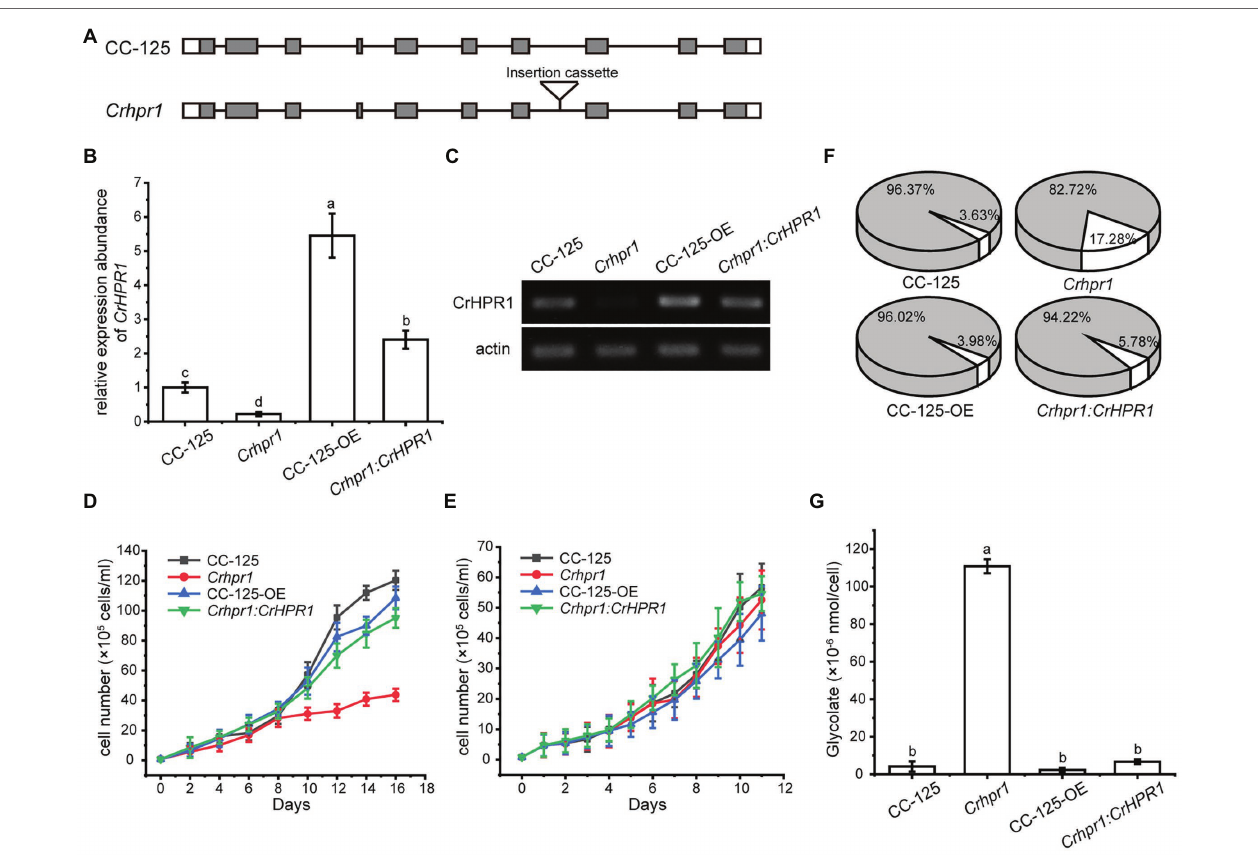
FIGURE 3 | Knockout of CrHPR1 impairs photorespiration. (A) Schematics of CrHPR1 structures in WT/CC-125 and Crhpr1 . (B) qRT-PCR analysis of CrHPR1 transcripts in the strains. (C) RT-PCR of analysis of CrHPR1 transcripts in the strains. Growth curve of strains in (D) air and (E) 3% CO 2 condition. (F) The ratio of oxidation and carboxylation reaction of ribulose bisphosphate carboxylase/oxygenase (Rubisco) in air. Carboxylation reaction: white sector. Oxidation reaction: gray sector. (G) Concentration of glycolate detected in the medium of each strain. Mean values ± SD presents data from three measurements. Means denoted by the same letter did not significantly differ at p <